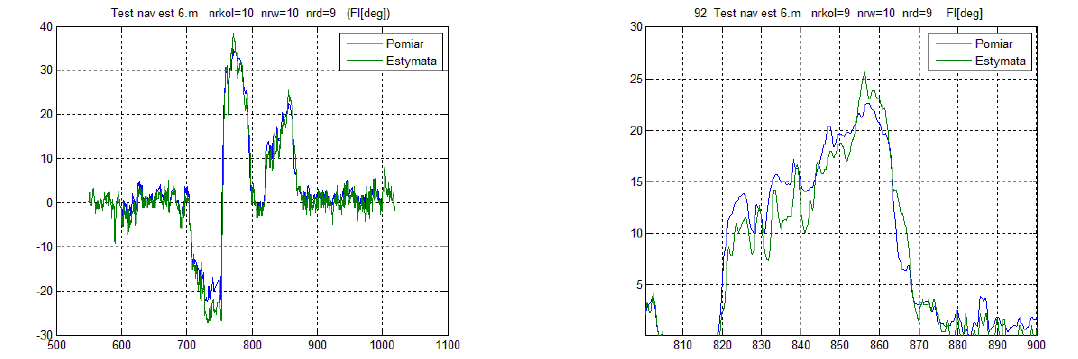
Figure 5. Roll angle [deg] estimation and enlarged fragment on the right – algoritm is described in sub-chapter 2.4